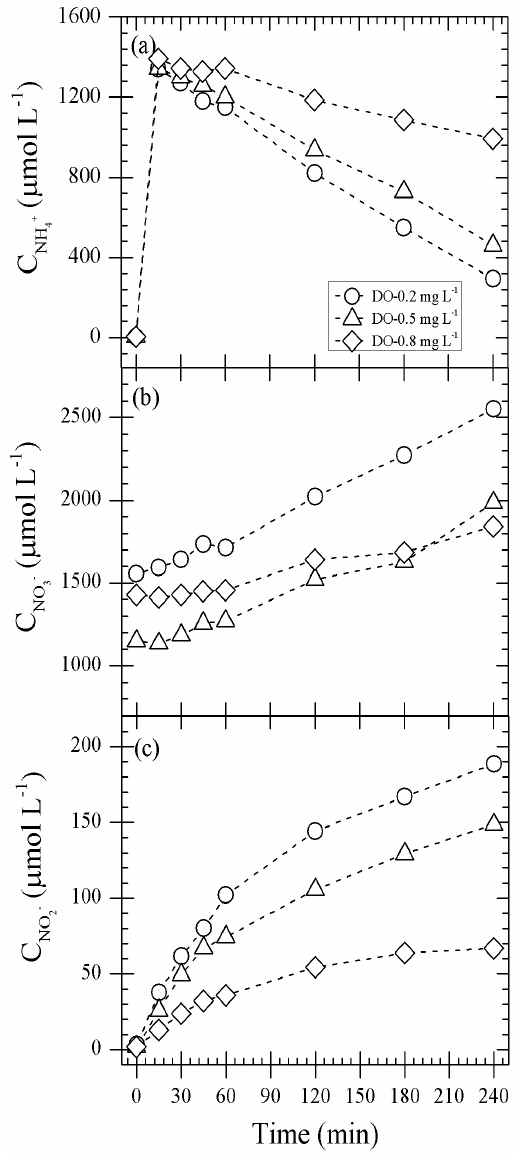
Fig 3. Distribution of inorganic nitrogen species (a: NH 4+ , b: NO 2- , c: NO 3- ) during the three experiments with different DO settings (0.2, 0.5 and 0.8 mg L –1